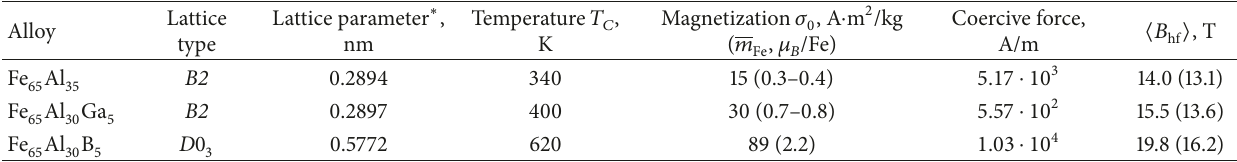
Table 1: Structural and magnetic parameters of quasi-ordered alloys Fe 65 Al 35 and Fe 65 Al 35−𝑥 M 𝑥 (M 𝑥 = Ga, B; 𝑥 = 5 at.%): the lattice type and parameter; the magnetic ordering temperature 𝑇 𝐶 ; the saturation magnetization 𝜎 0 , in brackets—the magnetic moment per Fe atom 𝑚 Fe ; the coercive force 𝐻 𝐶 ; the average HFF ⟨𝐵 hf ⟩ calculated from p (𝐵 hf ) , in brackets— ⟨𝐵 hf ⟩ at 𝐻 ext = 5 T.